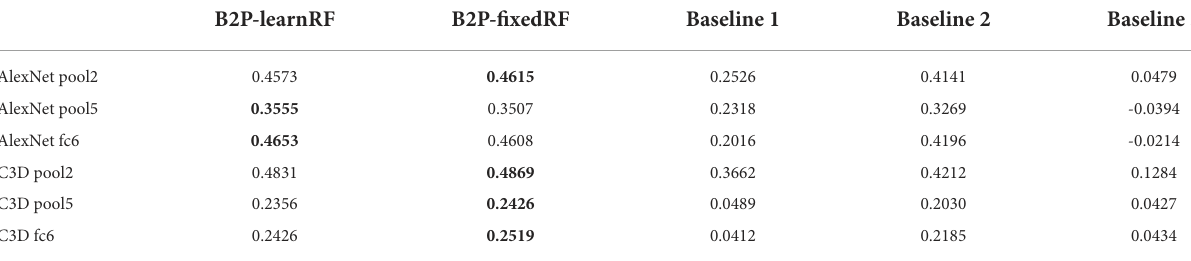
TABLE 1 Baseline experiment correlation values .